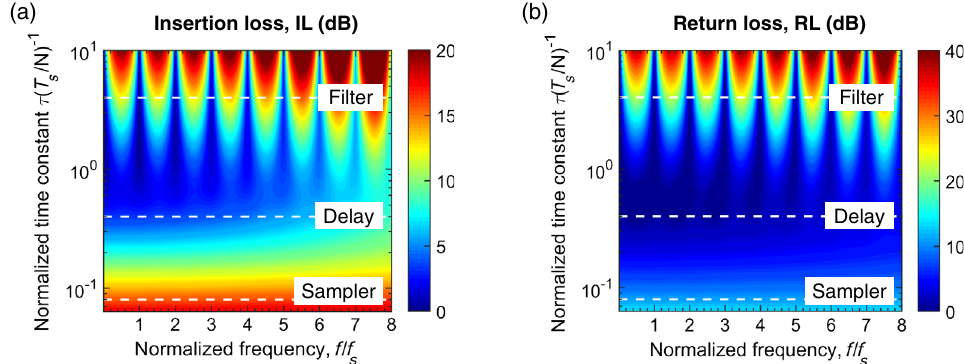
FIG. 4. (a) Insertion loss IL ¼ − 20 log 10 j S 21 j dB and (b) return loss RL ¼ − 10 log 10 ð 1 − j S 11 j 2 Þ dB of the commutated capacitor network shown in Fig. 1(a) versus the normalized frequency f=f ( f is the modulation frequency) and the RC time constant τ ¼ Z 0 C s s =N over which each switch remains closed. The three dashed horizontal lines indicate the three representative normalized by the time T s values of τ for C ¼ 5 pF, C ¼ 0 . 5 pF, and C ¼ 0 . 1 pF corresponding to network operating, respectively, as a filter, a delay element, and a sampler. All other parameters are the same as in Fig.